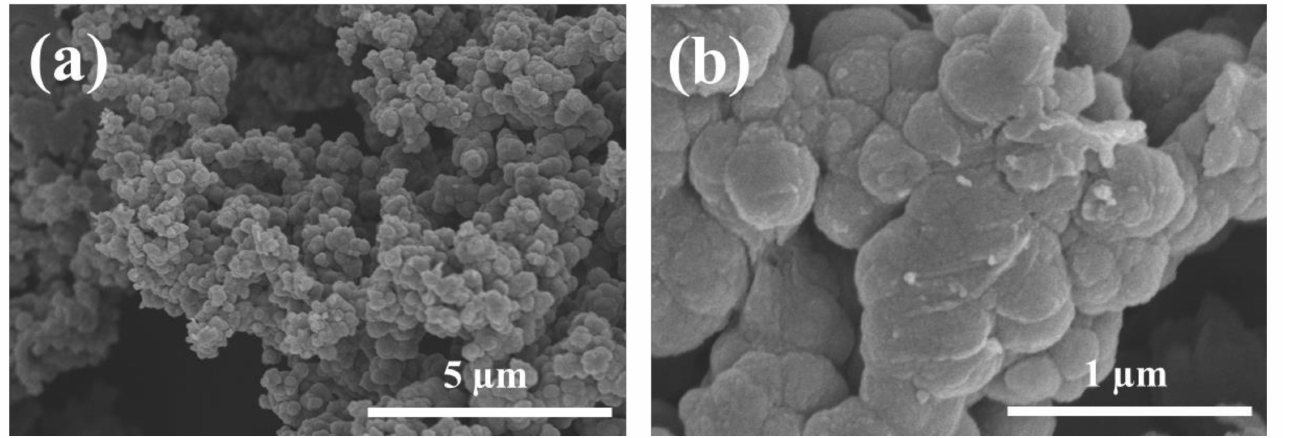
Figure 1. The SEM images of polypyrrole (PPy) particles with different magnifications of × 10k ( a ) and × 50k ( b